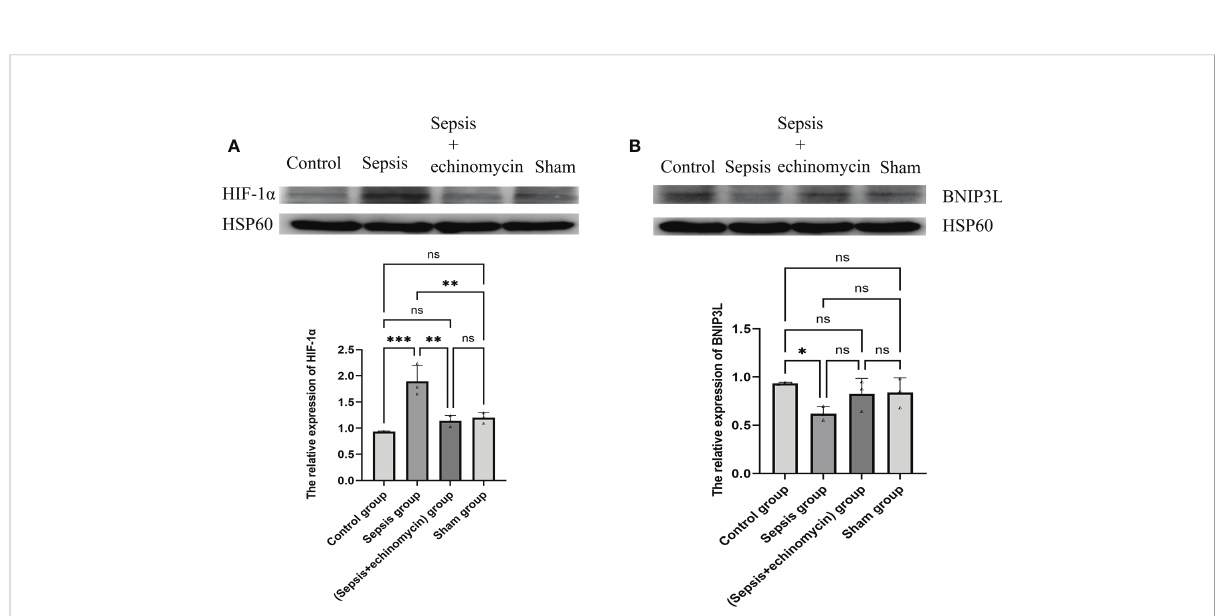
FIGURE 10 The HIF-1 a and BNIP3L protein expression in mitochondrion of hippocampus neuron cell. (A) : HIF-1 a protein expression in mitochondrion; (B) : BNIP3L protein expression in mitochondrion. Compared with other three groups, sepsis up-regulated the HIF-1a and down-regulated BNIP3L protein expression in mitochondrion of hippocampus neuron cell.*: p < 0.05, **: p < 0.01, ***: p < 0.001, ns: p >